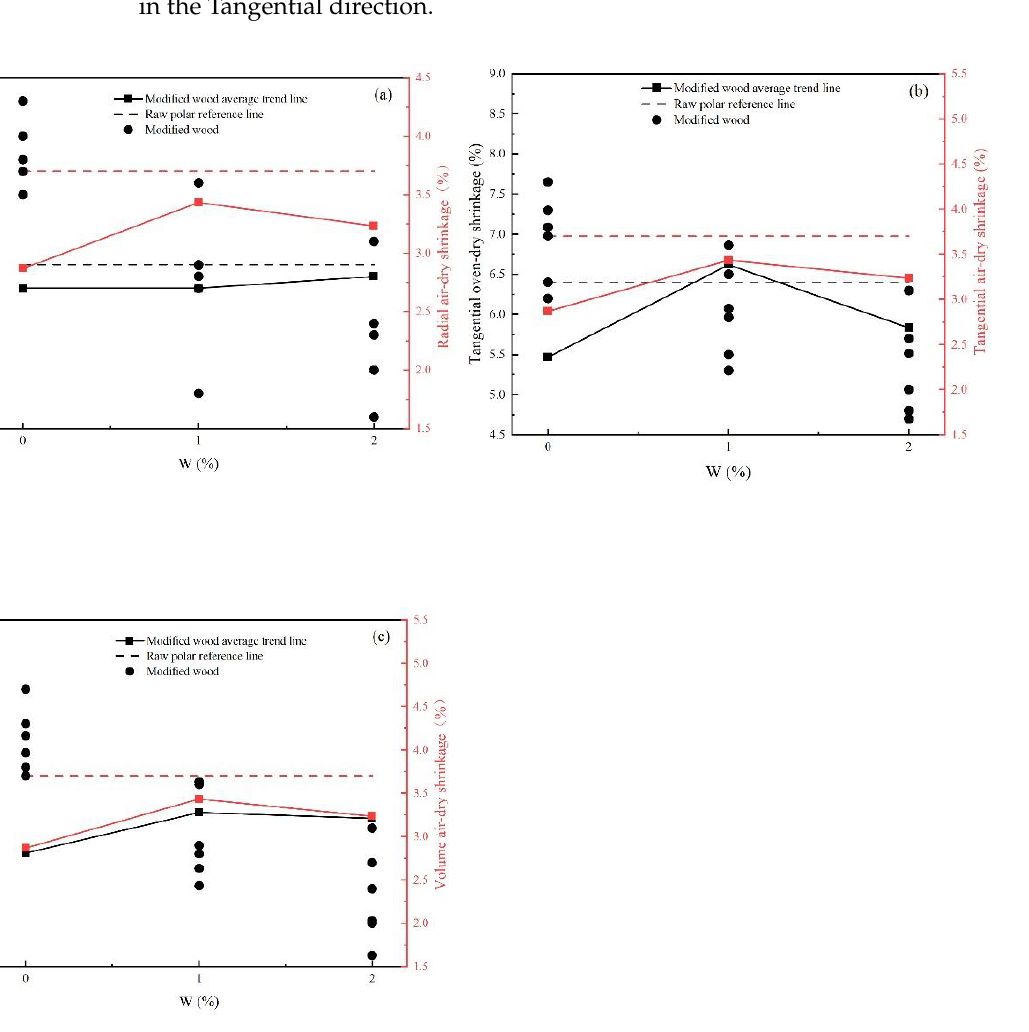
Figure 2. Comparative analysis of dry shrinkage of modified wood based on W: ( a ) radial oven-dry and air-dry shrinkage; ( b ) tangential oven-dry and air-dry shrinkage; ( c ) volume oven-dry and air-dry shrinkage.